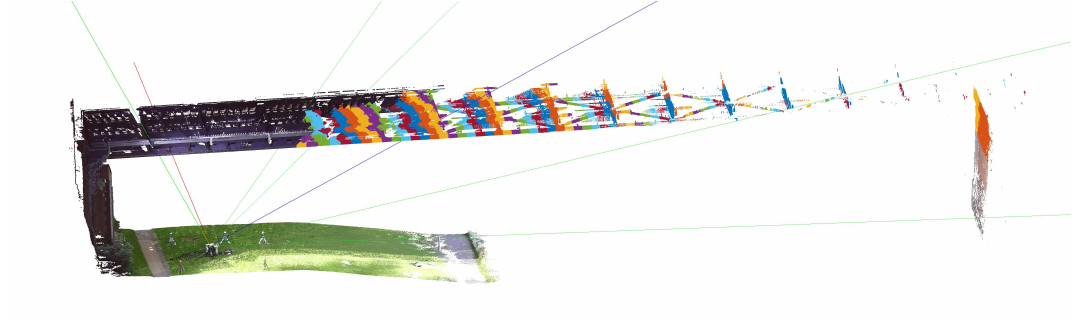
Figure 11. Perspective view of Setup 3 with color-coded resolution cells for the